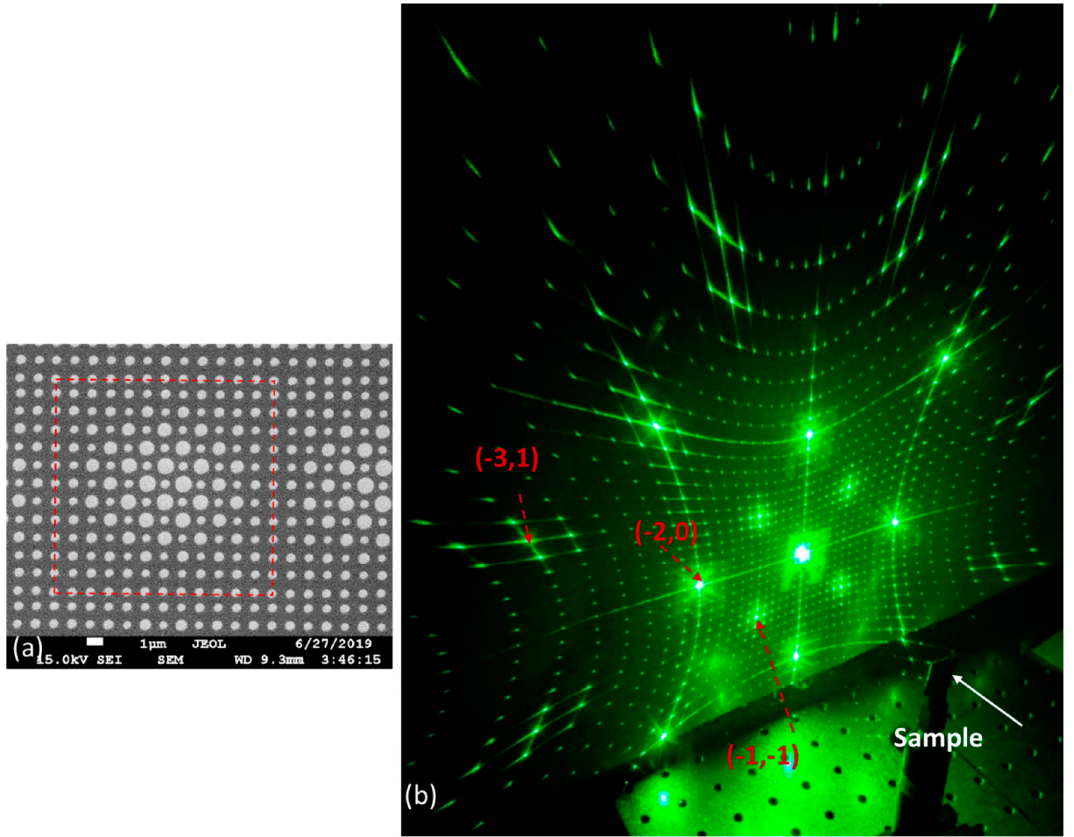
Figure 2. ( a ) SEM of fabricated GPSC in PMMA. ( b ) Diffraction pattern from the GPSC using 532 nm laser. 532 nm